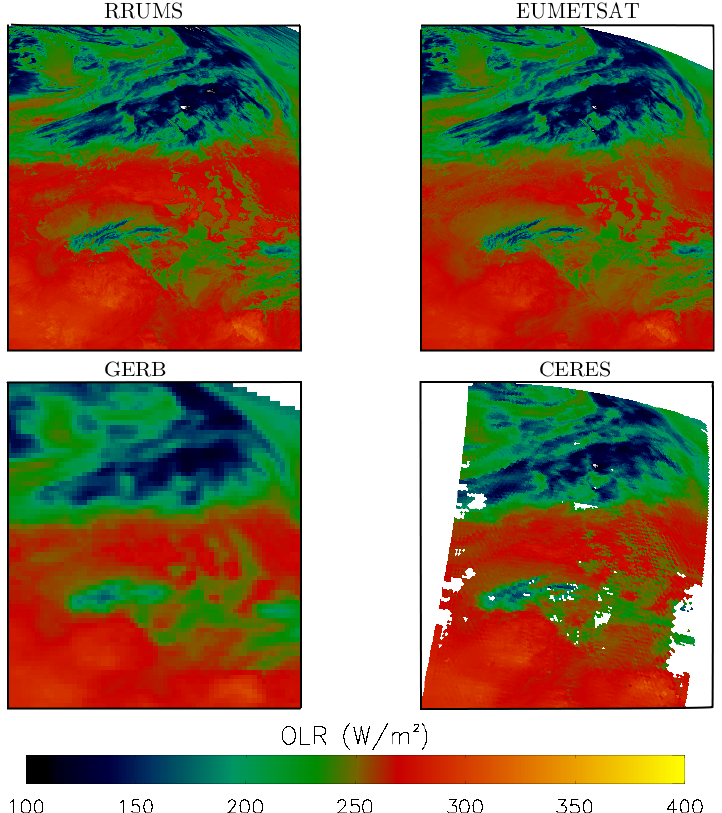
Fig. 6. Comparison between the SEVIRI-based methods to derive OLR (RRUMS and the EUMETSAT algorithm) and the two current irradiance measurement instruments (CERES and GERB). The blank areas are missing data due to the instrument characteristics. Same scene as Fig. 7. Date: 1 January 2007,